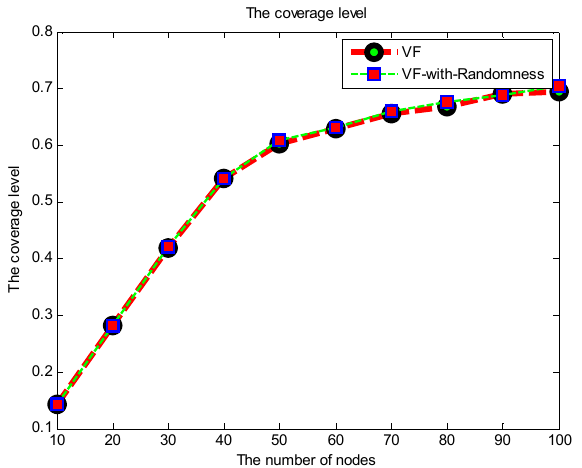
Figure 10. The coverage level achieved by the proposed approach with added randomness to the antenna communication range.